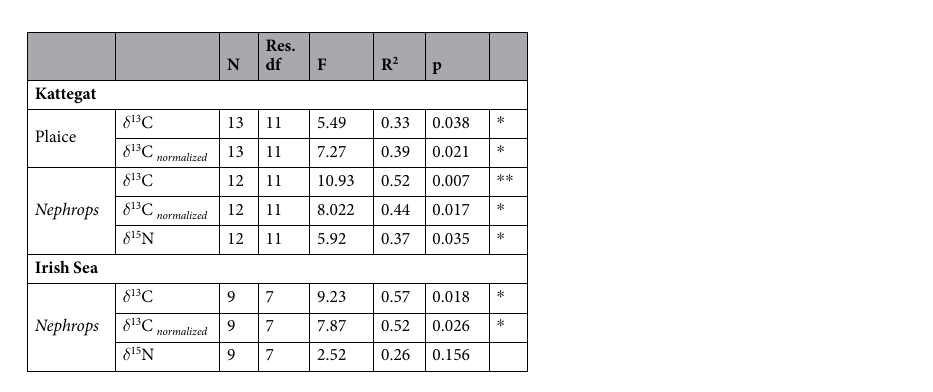
Table 3. Least square regression models of δ 13 C and δ 15 N against standardized body weight (as a proxy for condition). Weight values were obtained from the predicted GAMM model outputs and δ 13 C and δ 15 N observed measurements. Both δ 13 C and δ 13 C normalized were used in the analysis. A significant relationship of both δ 13 C and δ 13 C normalized verified that the relationship was not related to the lipid content of the tissue. Res.df are the residual degrees of